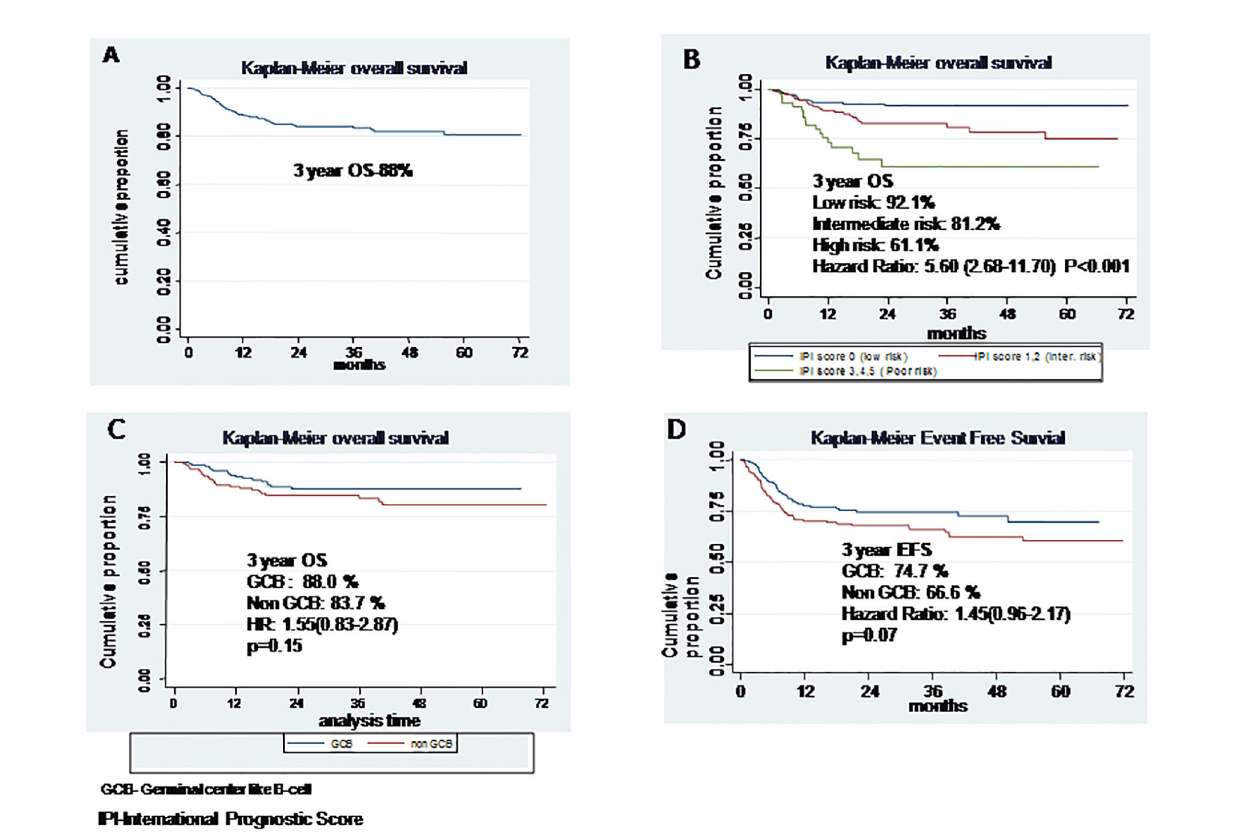
FIGURE 1 | (A) Overall survival, (B) Overall survival based on International Prognostic Score, (C) Overall survival based on cell of origin, (D) Event free survival based on cell of